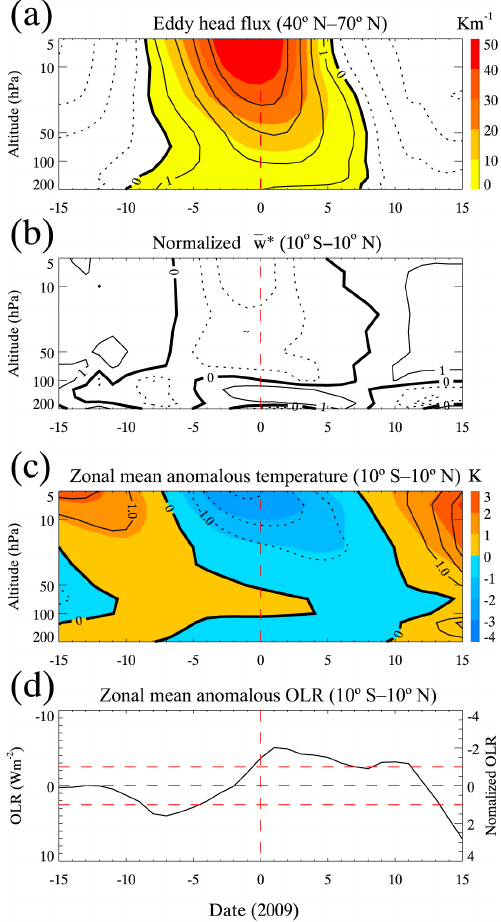
Figure 2. The time altitude cross section of zonal mean (a) anoma- lous eddy heat flux averaged between 40 and 70 ◦ N shown in phys- ical value (color shades) and normalized value (contours), (b) the normalized anomalous vertical velocity averaged between 10 ◦ S and 10 ◦ N, and (c) the anomalous temperature averaged between 10 ◦ S and 10 ◦ N shown in physical value (color shades) and nor- malized value (contours). (d) The time series of anomalous OLR data averaged between 10 ◦ S and 10 ◦ N. The normalized values are calculated as anomalies normalized by standard deviation ( σ) . The red vertical lines indicate day 0, the central date of the 2009 SSW event. The dashed horizontal lines in (d) indicate zero and ± 1 σ